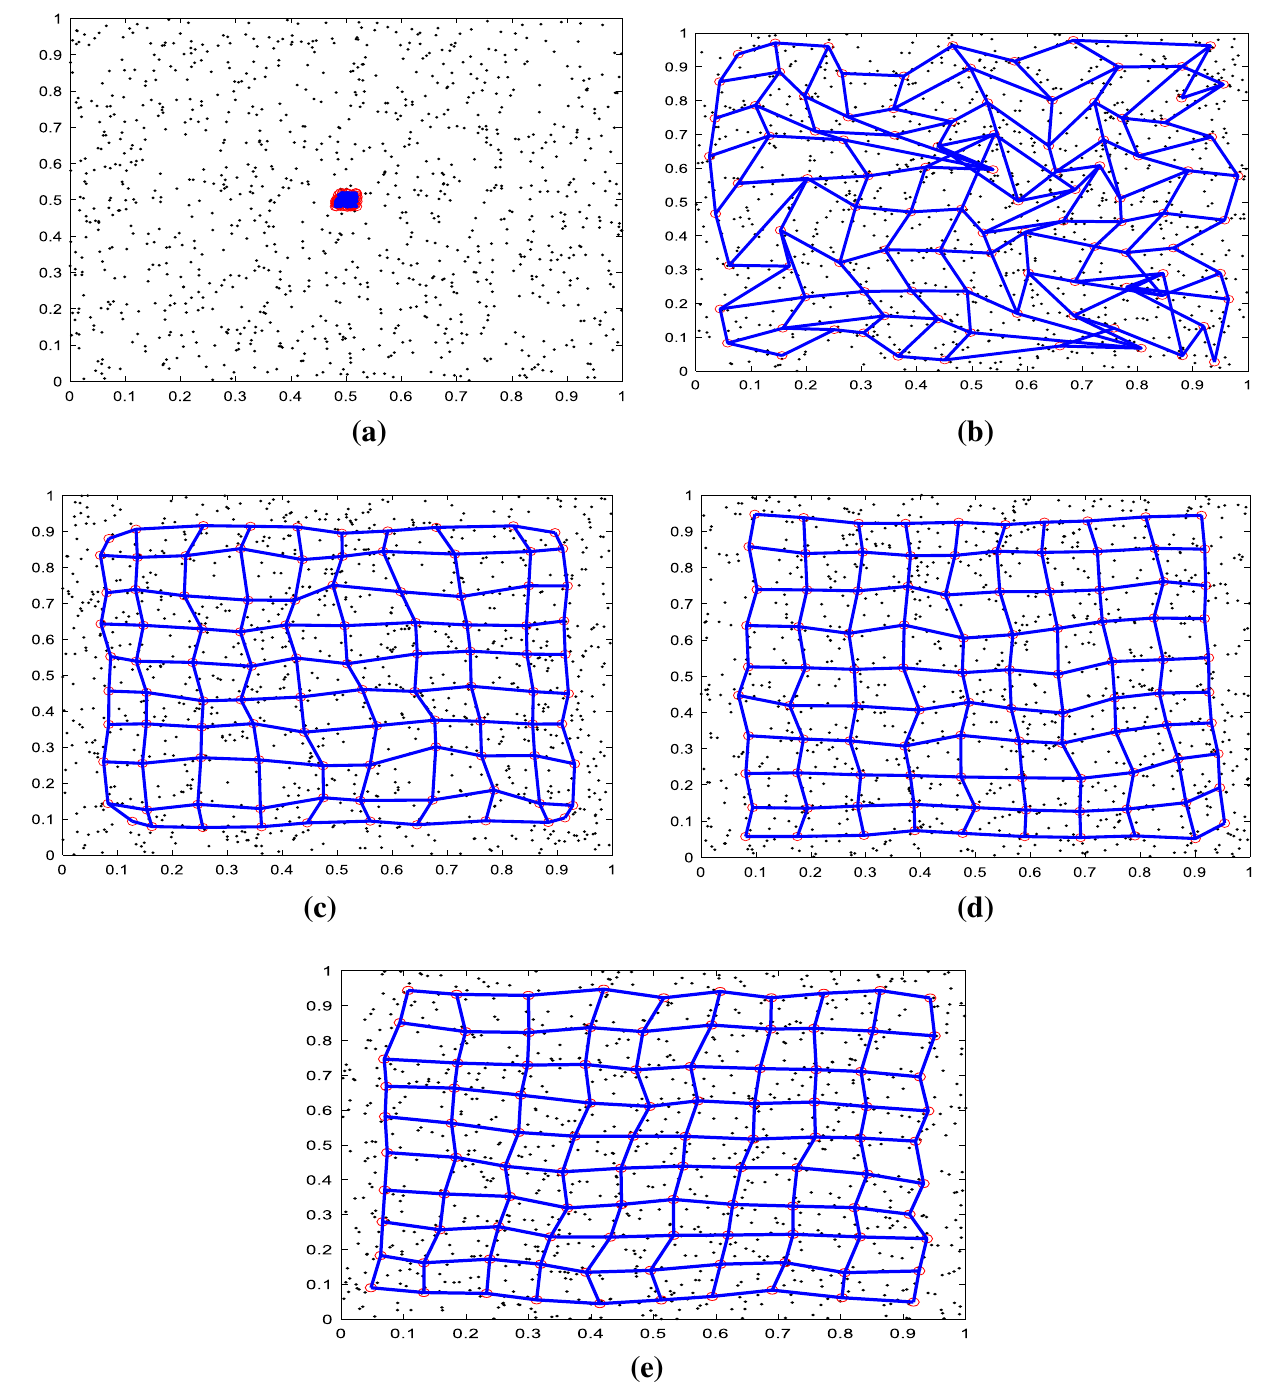
b TopologyadaptationresultsforConventionalSOM, c